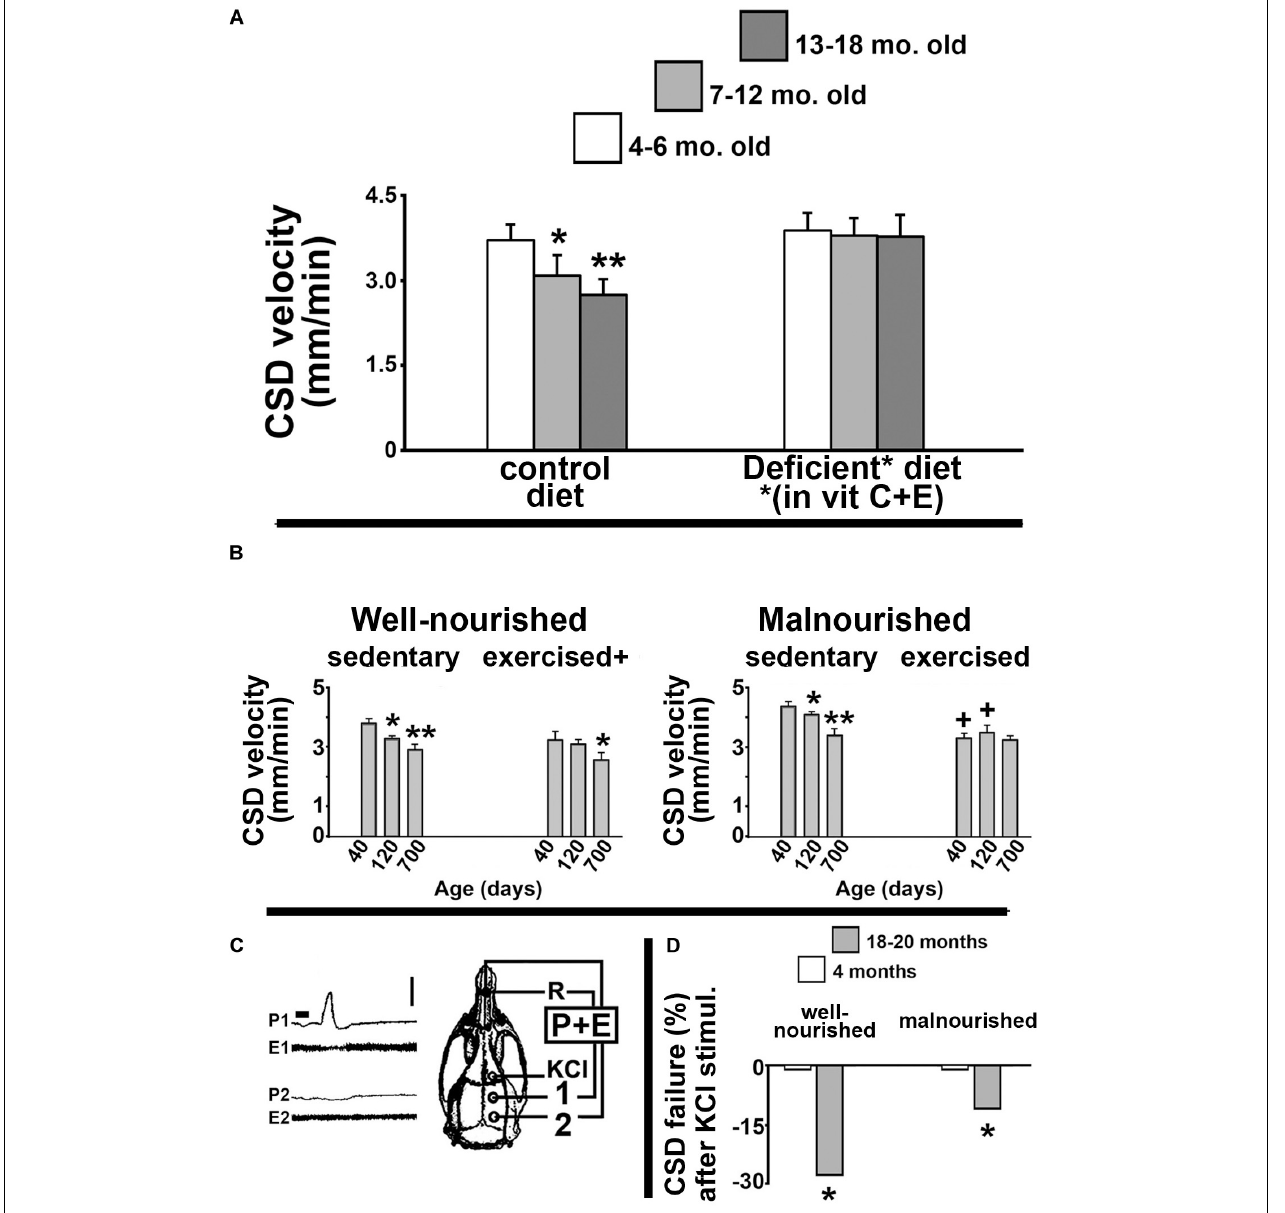
FIGURE 1 | (A) Propagation velocity (in mm/min) of cortical spreading depression (CSD) measured in rats from three age groups: 4–6-month, 7–12-month, and 13–18-month-old animals. Data are the means ± standard deviations from eight animals per age group. The inverse correlation between CSD velocity and age (left panel) disappeared when animals were fed a diet that was deficient in the antioxidant vitamins C and E (right panel). ∗ p < 0.05 compared to the 4–6-month-old group. ∗∗ p < 0.005 compared to the two younger age-groups (ANOVA plus Holm-Sidak test). The skull diagram illustrates the area of KCl application to elicit CSD (in the frontal cortex), the two recording points (1 and 2, on the parietal cortex), and the point of placement of the common reference electrode (R, on the nasal bones). Data in this non-published panel (A) are from our previous publication (Guedes et al., 1996). (B) Mean ± standard deviation of the CSD Propagation velocity (in mm/min) in well-nourished (left panel) and malnourished (right panel) rats. In both nutritional groups, three age subgroups were studied: 40, 120, and 700 days of life. ∗ p < 0.05 compared with the corresponding 40-day-old group. ∗∗ p < 0.05 compared with the 40-day- and 120-day-old groups. + p < 0.05 compared with the corresponding sedentary groups. (C) Recordings of DC slow potential change (P) and electrocorticogram (E) of CSD illustrating failure of CSD propagation in a 700-day-old rat. Note that after being elicited by KCl, CSD reached the recording point 1, but failed to reach point 2. (D) Percentage of KCl-elicited CSD episodes that failed to propagate to the remote recording point (2). ∗ p < 0.05 compared to the corresponding younger (4-month-old) group. Data in the non-published panels (B,D) are from our previous publication (Batista-de-Oliveira et al., 2012). Traces shown in part C corresponds to panel B of Figure 3 from the paper by Batista-de-Oliveira et al. (2012). These traces are here reproduced with permission (No. 4532461257722) from the publisher.